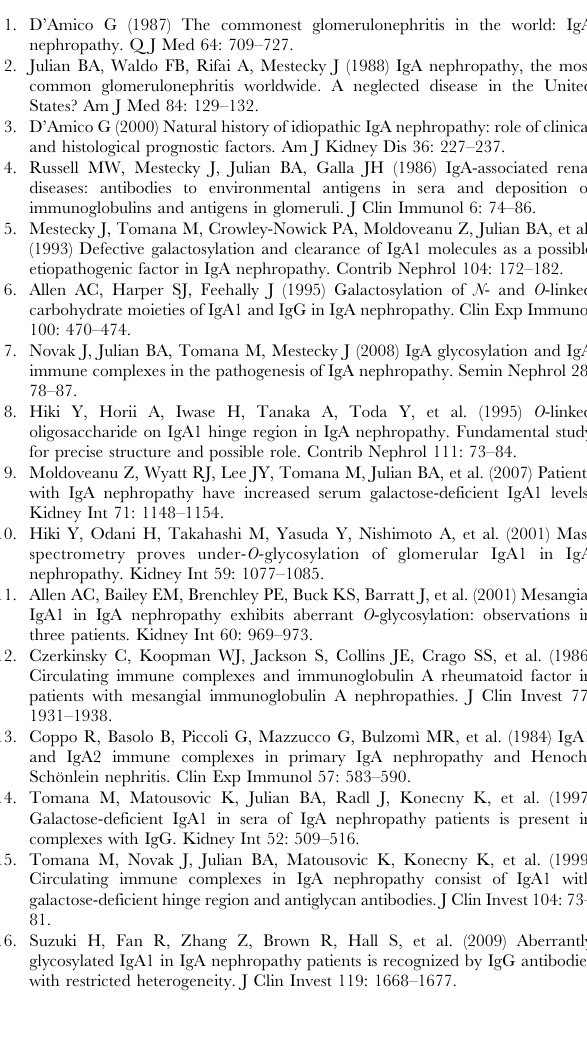
Table S1 Serum levels of biomarkers in high-protein- uria and low-proteinuria CKD control